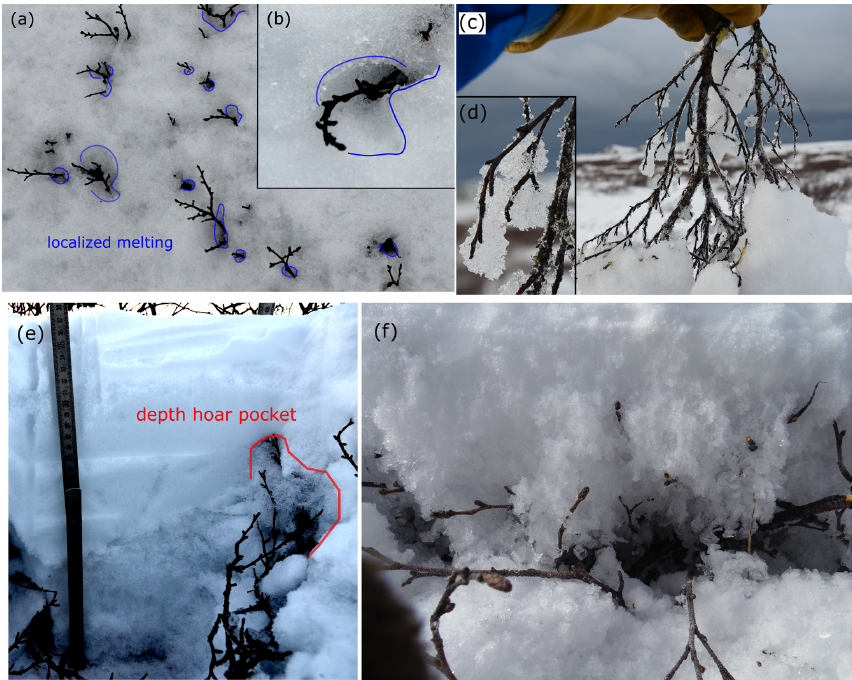
Figure 8. Photos showing observations of localized snow melting around branches (a, b) , a branch cut from a buried shrub with attached clusters of melt–freeze grains (c, d) and the formation of depth hoar pockets around buried branches (e, f) . Photos were taken during the measurement campaign from 29 October to 6 December 2015. In (e) the contrast of the photo was increased to better reveal the depth hoar